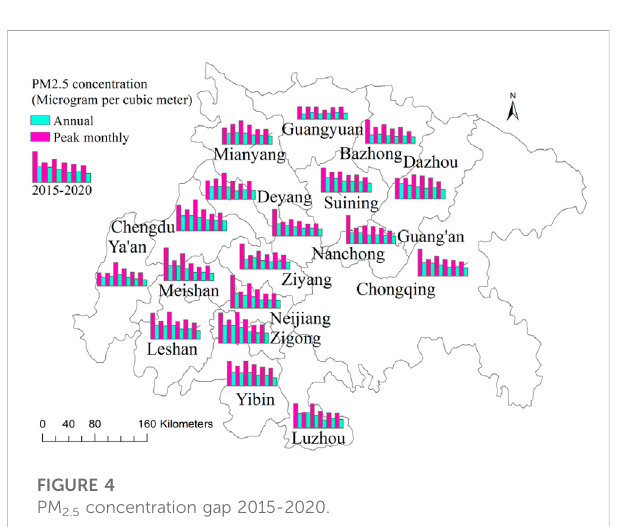
FIGURE 5 PM 2.5 maximum and minimum